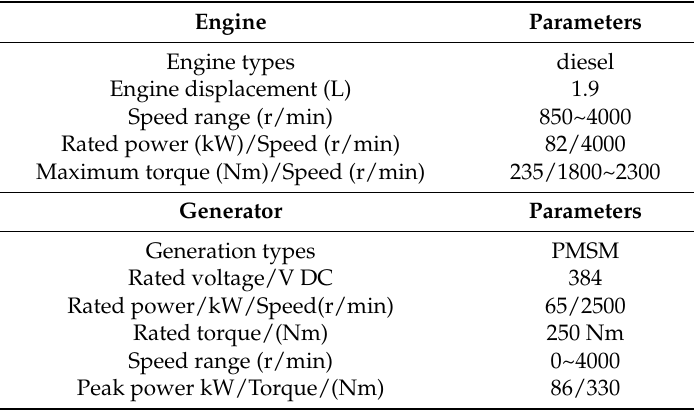
Table 2. APU specification